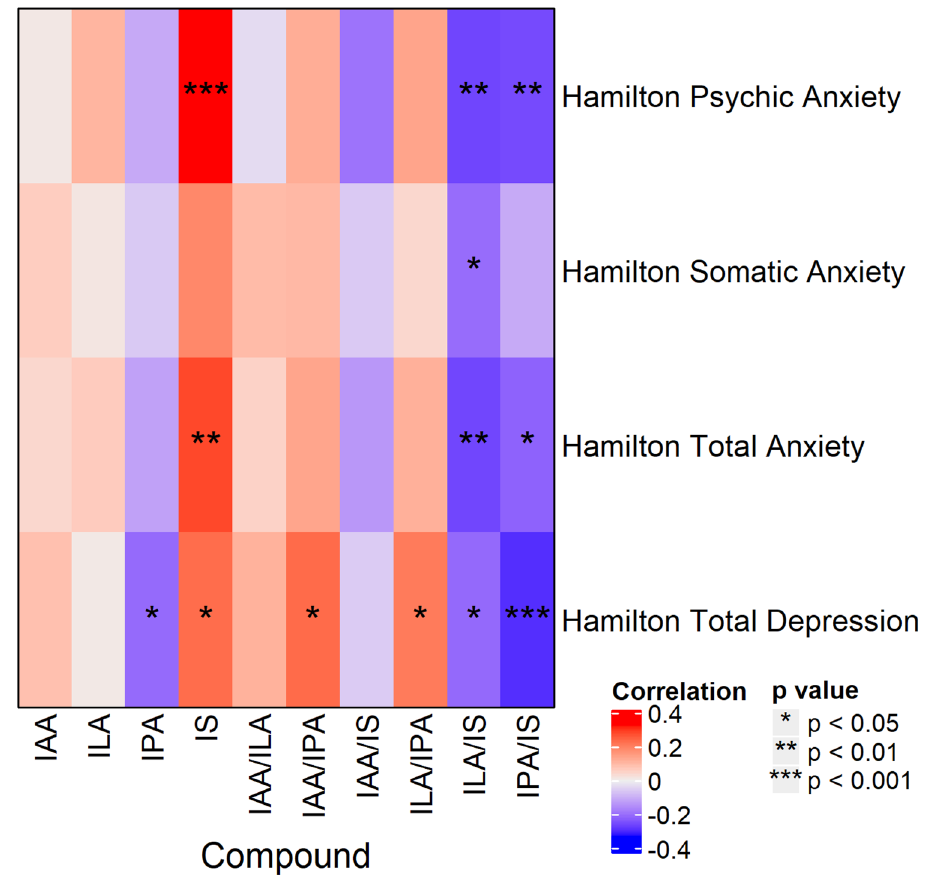
Figure 2. Heat map of Holm-corrected partial Spearman rank correlations between baseline indole abundance/ ratio and Hamilton Anxiety scores and Hamilton Depression scores, after accounting for age, sex, and